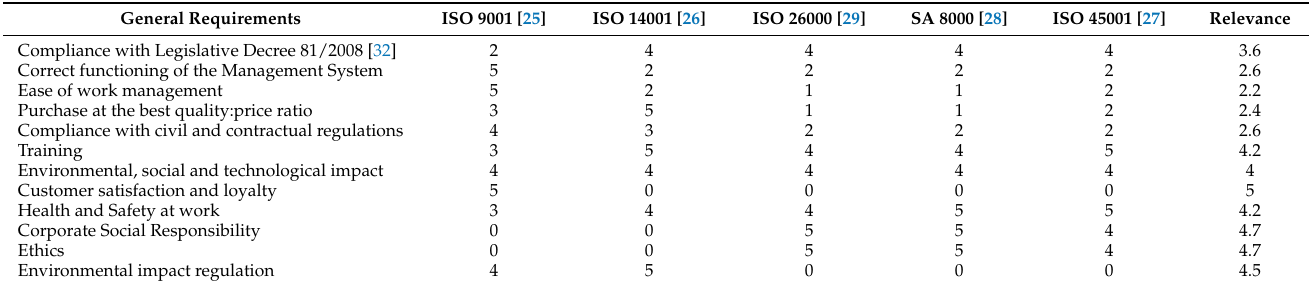
Table 2. Integrated Balance Sheet for Relevance.